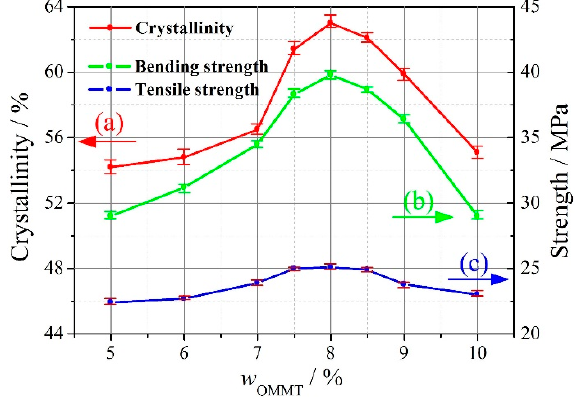
Figure 5. The crystallinity, bending strength, and tensile strength of the OMMT-modified UHMWPE with increasing amounts of OMMT. ( a ) Crystallinity, ( b ) bending strength, ( c ) tensile strength (repeated three times).